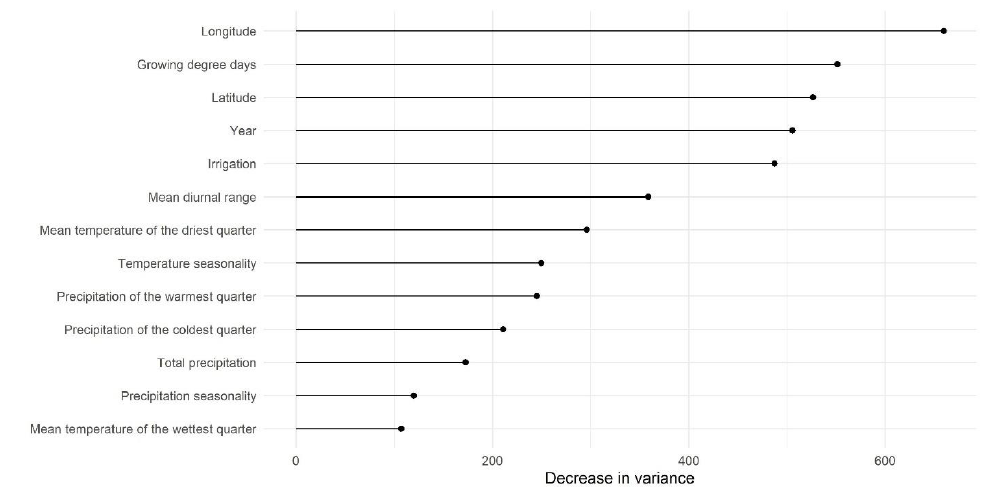
Figure 4. Permutation variable importance for the reduced resubstitution models of corn yield. The covariates appear on the y-axis and their contribution to decreased variance on the x-axis. Variables are listed in order of importance, with the most important variable being longitude and least important being mean temperature of the wettest quarter; see Table S1 for variable names, units, and descriptions.